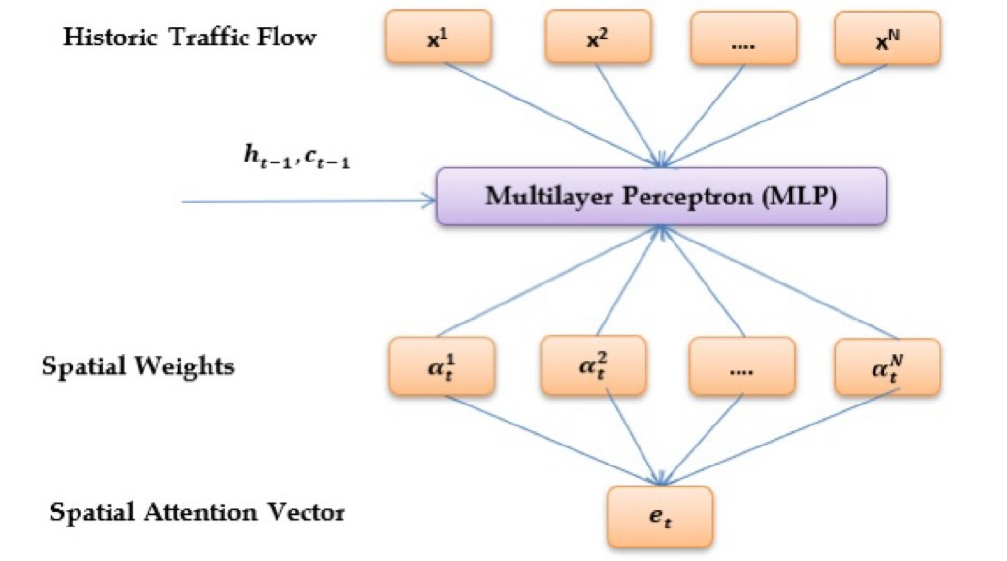
Figure 3. Spatial attention model in